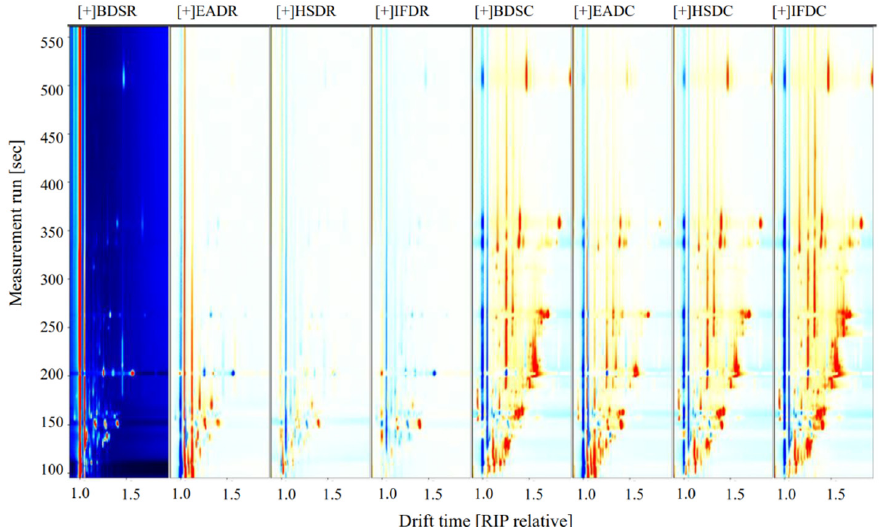
Figure 3. Volatile compound component spectra of raw (R) and cooked (C) sea bass subjected to different slaughter methods, using the BDSR group as the reference. IFD, ice faint to death; HSD, head shot control stun death; EAD, eugenol anesthesia to death slaughter; BDS, bloodletting to death slaughter.